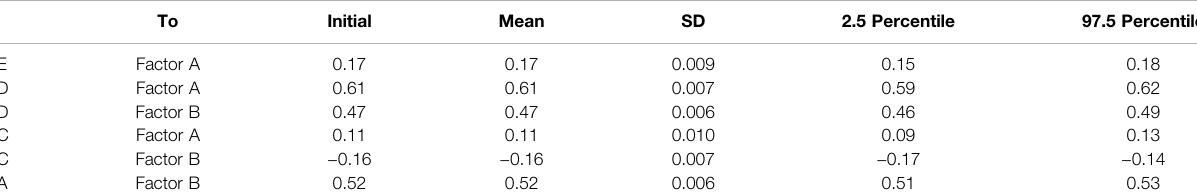
TABLE 3 | PLSPM path coef fi cients ofcausal factor relationships with the original value before bootstrap validation, and the mean, standard deviation, and 95% con fi dence interval range after bootstrap validation with 500 iterations. From To